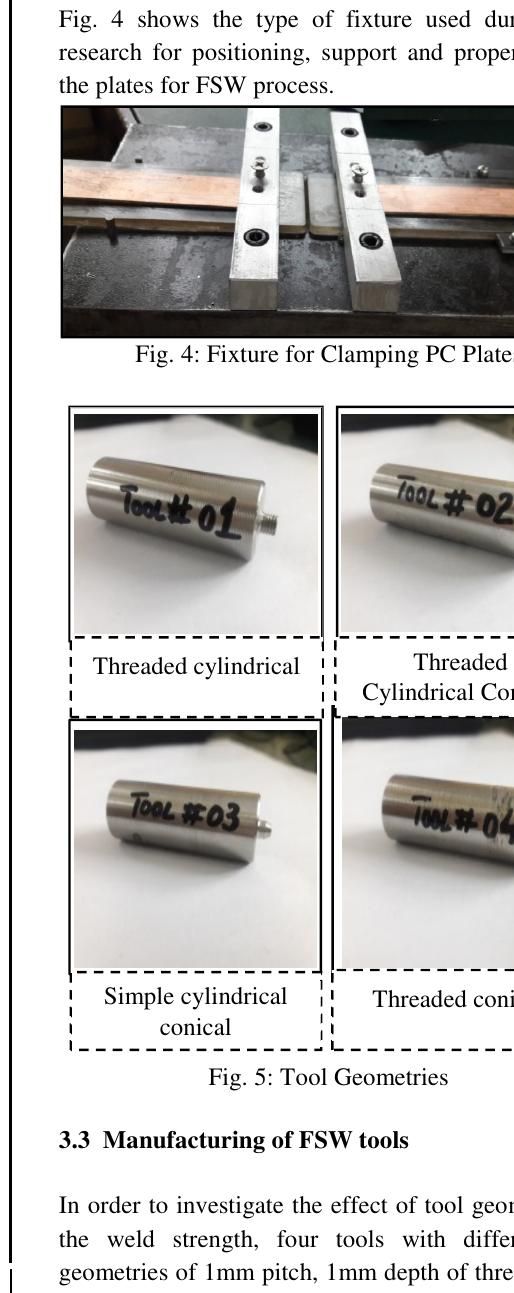
Fig. 3: Mold Assembly After Machining